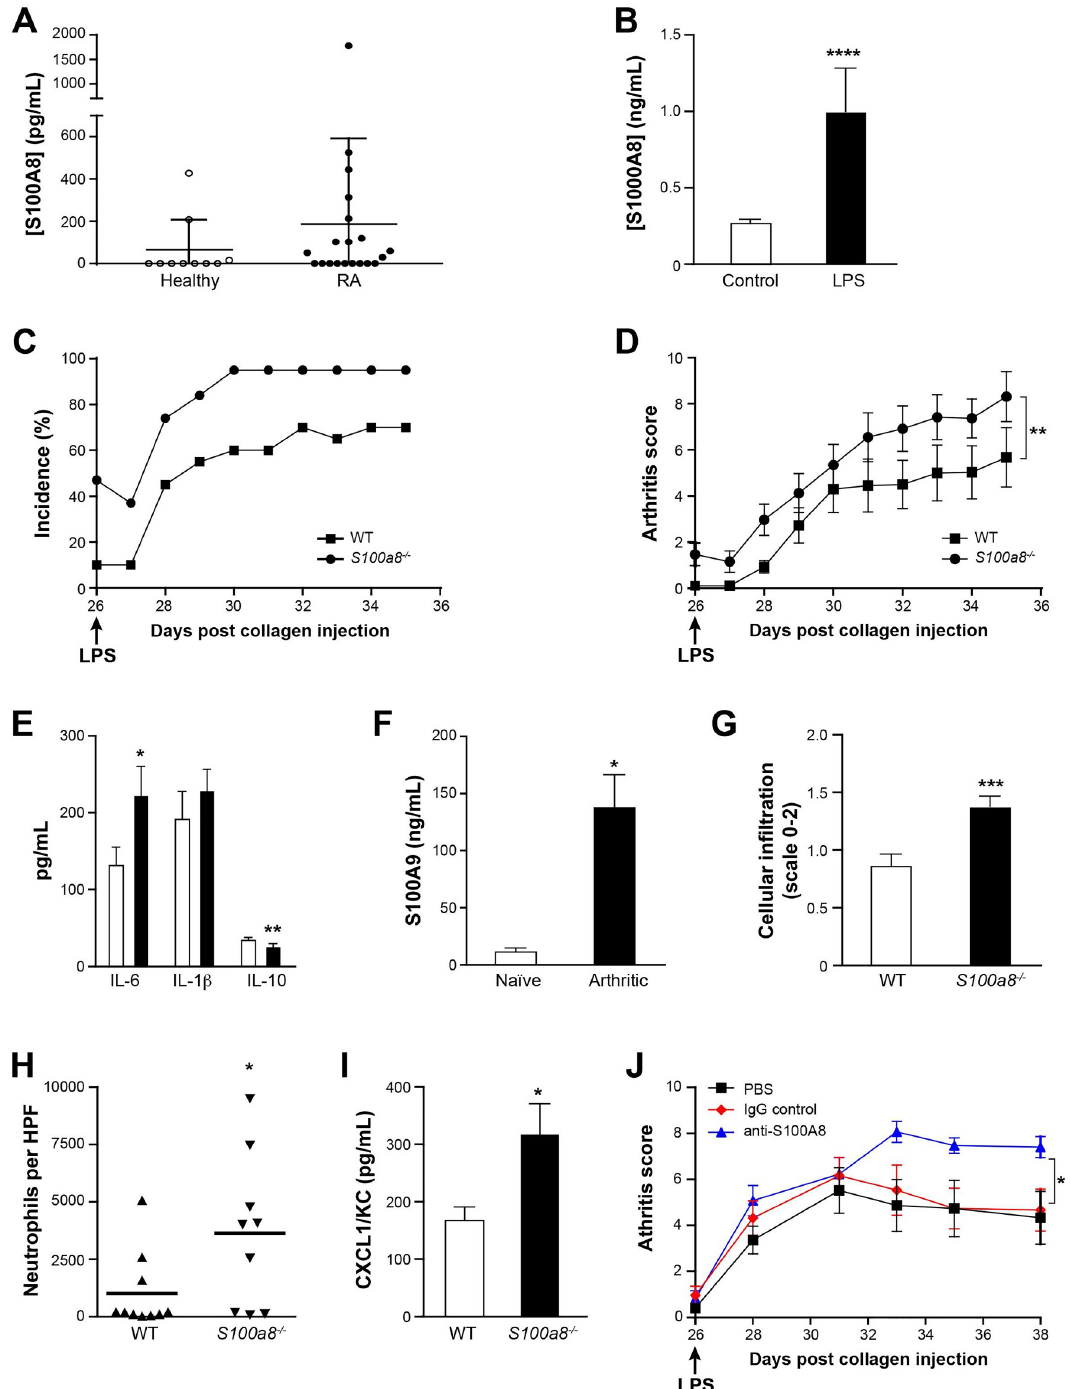
Fig 4. S100A8 mitigates arthritis. (A) Presence of S100A8 homodimer in the plasma of 20 rheumatoid arthritis patients and 10 age- matched and sex-matched healthy donors. S100A8 was quantified using an in-house ELISA. (B) Secretion of S100A8 homodimer by human peripheral blood neutrophils stimulated with LPS (100 ng/mL). S100A8 in culture supernatant was quantified using an in- house ELISA (12 healthy donors). (C) Incidence of collagen-induced arthritis in WT and S100a8 -/- mice. (D) Arthritis clinical score as measured by impartial observers (n = 20 for WT and n = 19 for S100a8 -/- ; �� based on GEE analysis). (E) Expression of IL-6, IL-1 β and IL-10 in paws of WT and S100a8 -/- mice (n = 18). (F) Expression of S100A9 in the paws of na ï ve and arthritic S100a8 -/- mice (n = 4 na ï ve and n = 19 arthritic). (G) Histological assessment of cellular infiltration into joints (scale of 0–2) as assessed by two